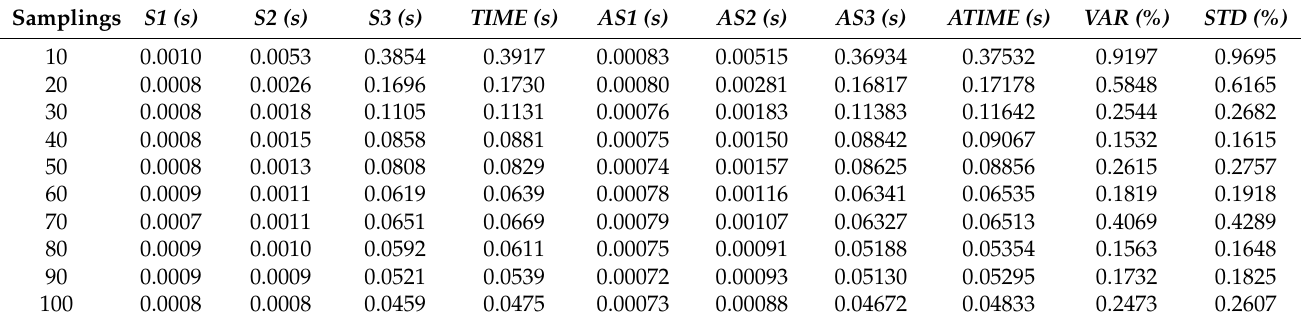
Table 3. The different run indicators of different 3D point cloud samplings.